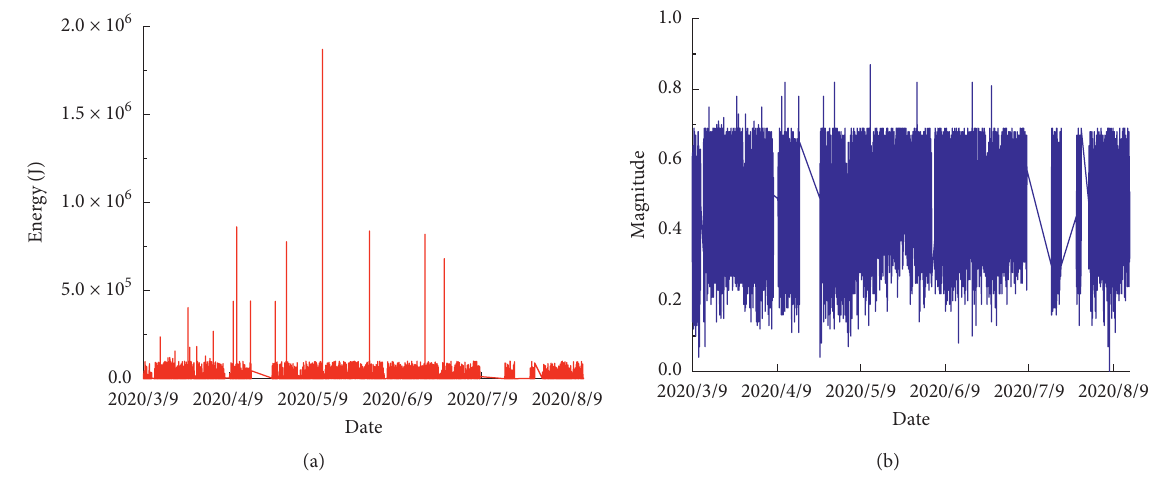
Figure 13: Microseismic monitoring data. (a) Energy. (b)